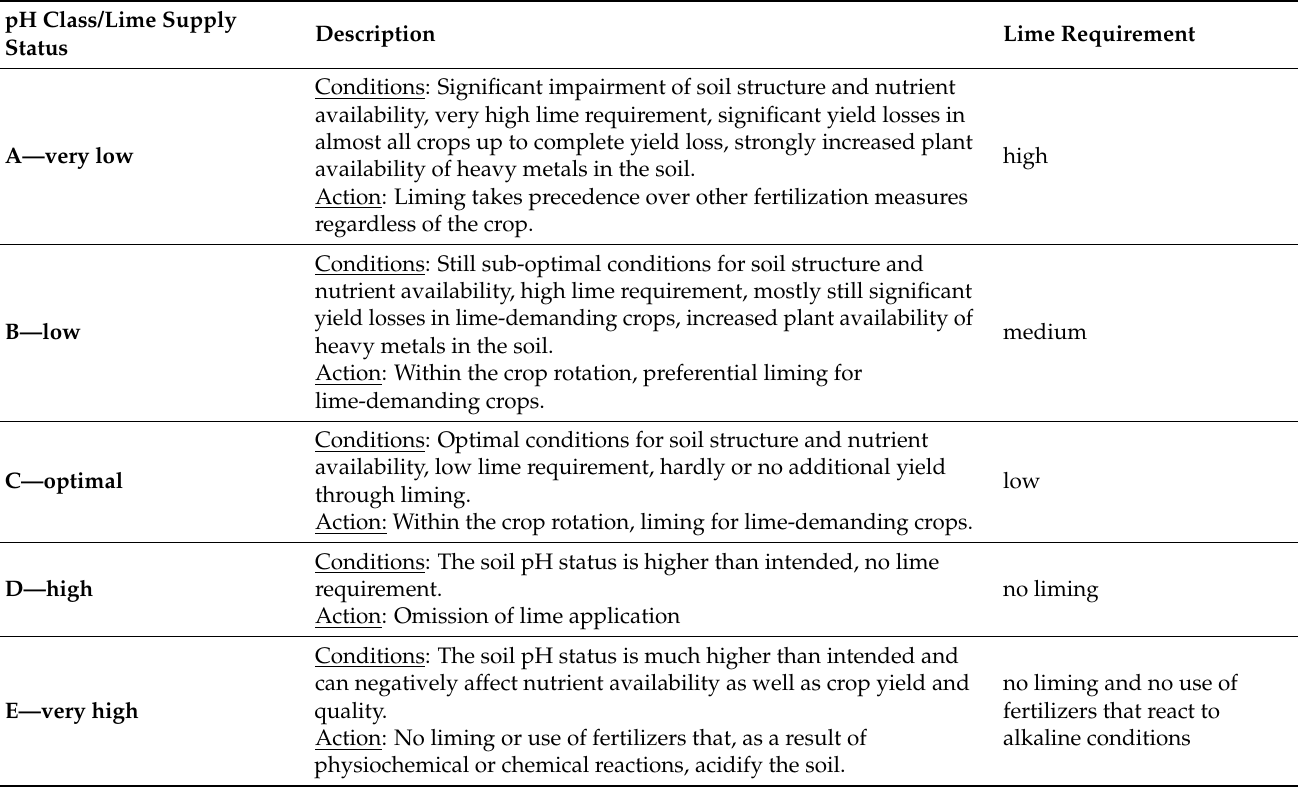
Table 1. Soil pH and lime requirement classes of the Association of German Agricultural Investigation and Research Institutions (VDLUFA)